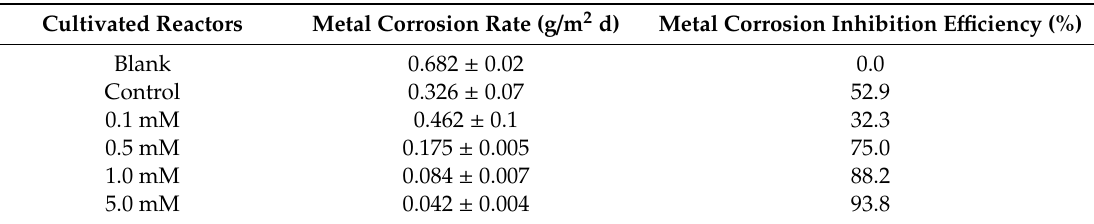
Table 4. Metal corrosion rate (g / m 2 d) and metal corrosion inhibition e ffi ciency (%) of the SCGS reactors at di ff erent concentrations (mM) and inoculated with enriched environmental sulfidogenic bacteria cultivated at high medium salinity of 5.49% NaCl in comparison to a blank reactor (un-inoculated with the sulfidogenic bacteria with high medium salinity) and a control reactor (inoculated with the sulfidogenic bacteria with high medium salinity).